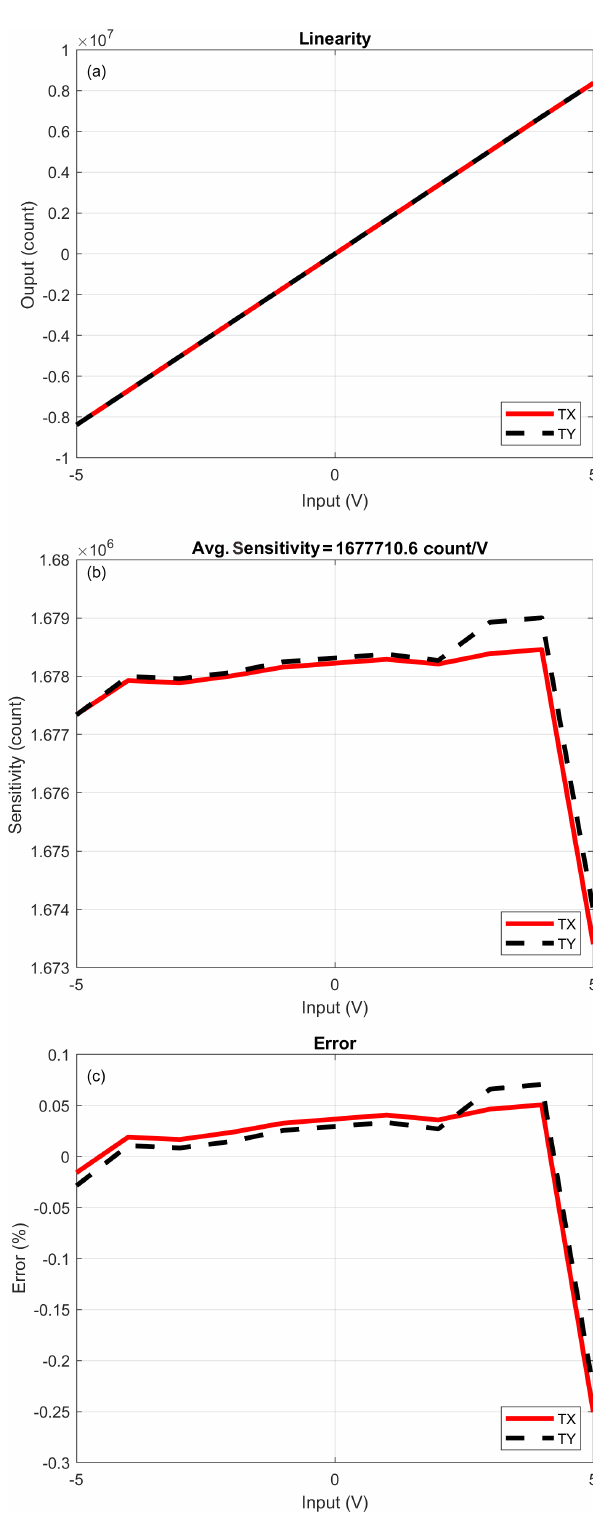
Figure 5. Calibration results for the electric channels of the OBEM01. (a) Linearity, (b) sensitivity and (c) error. The average sensitivity is 1358568047.8countsV − 1 , and the maximum error is < 0.8%.